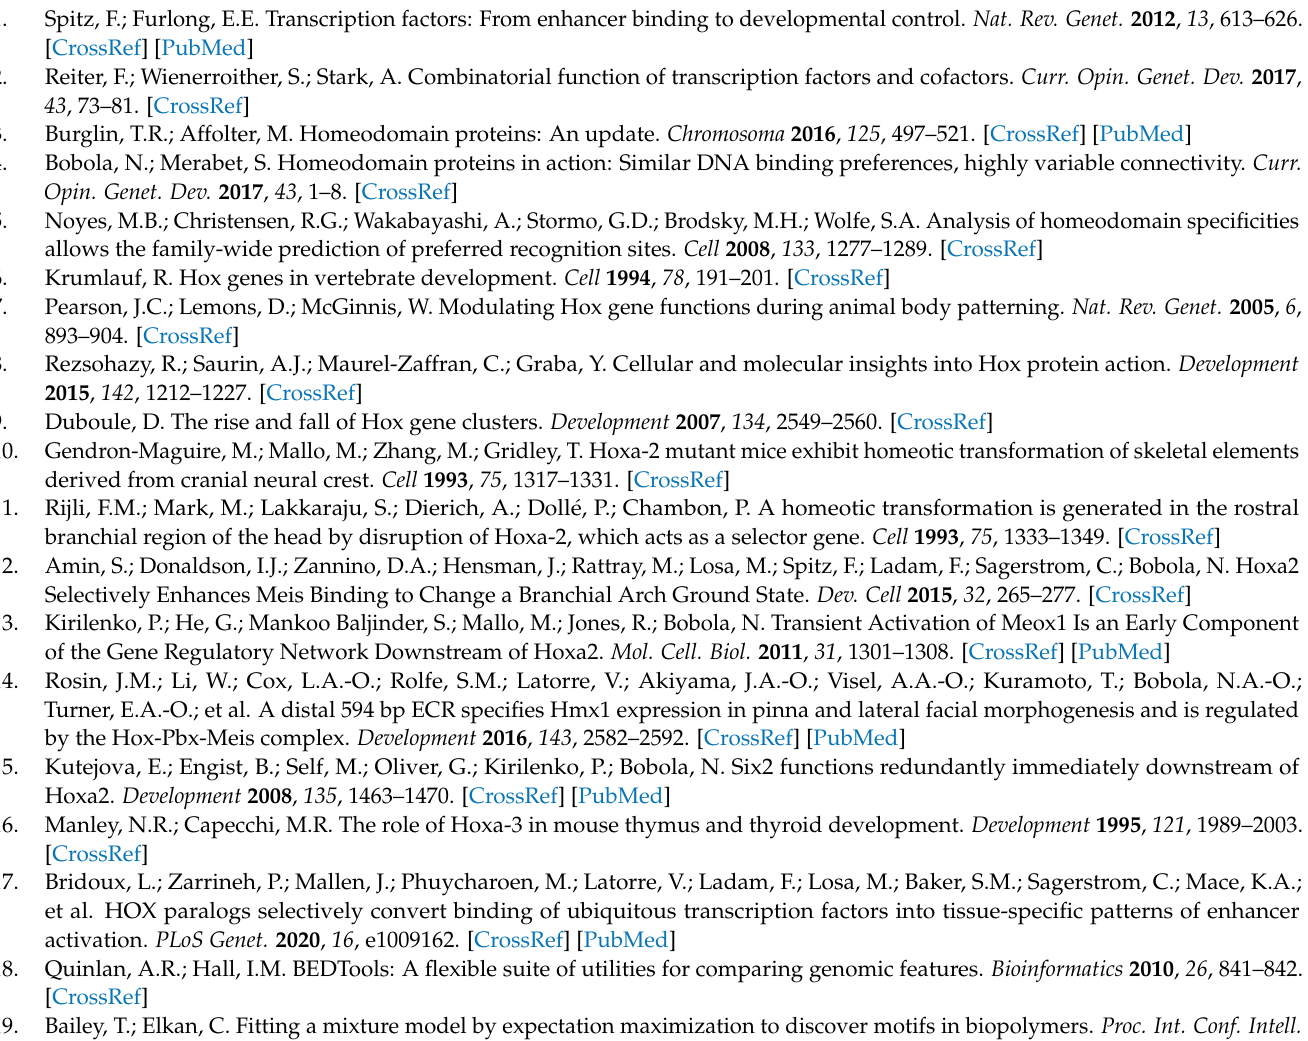
Figure 4B (2 replicates). Figure S3: A. Quantification of HOXA/PBX/MEIS bands from experiment in Figure 4C (3 replicates). B. Quantification of PBX/MEIS (PM) band from experiment in Figure 4C (3 replicates). C. Quantification of HOXA bands from experiment in Figure 4C (3